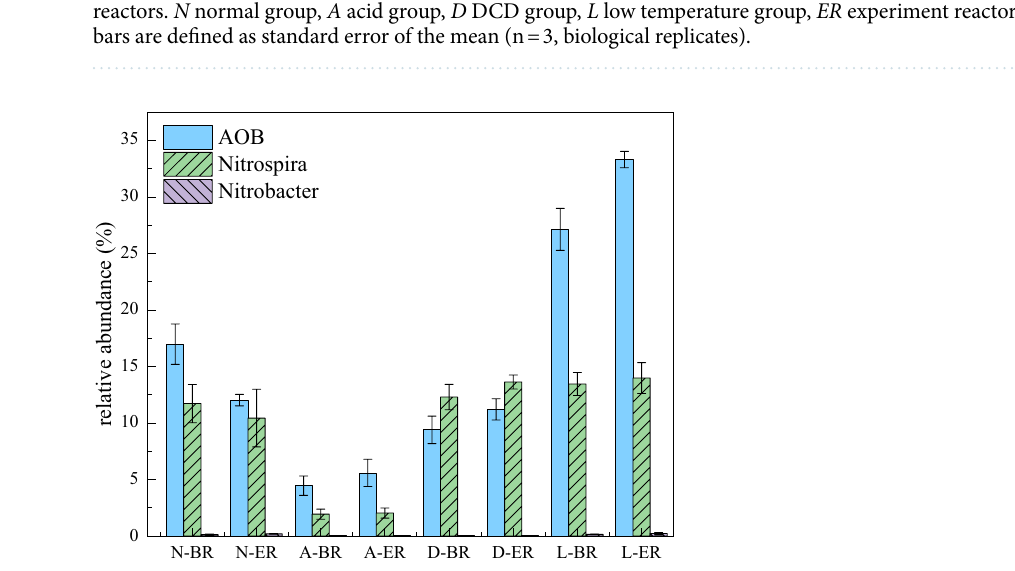
Figure 4. The abundance ratio of AOB and NOB to total bacteria in four groups. N normal group, A acid group, D DCD group, L low temperature group, BR blank reactor, ER experiment